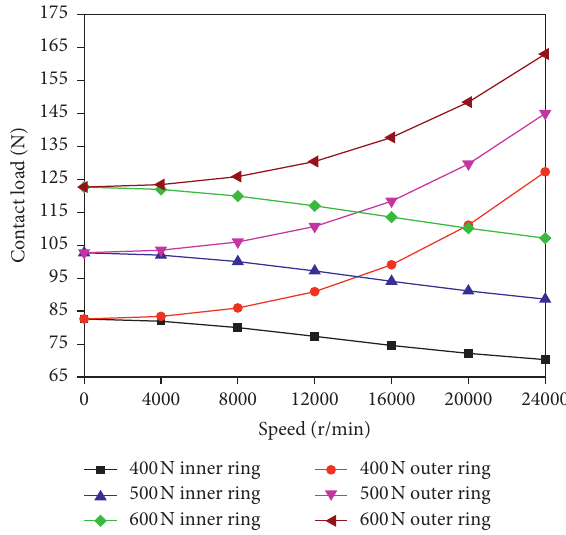
Figure 11: Influences of the speed and preload on contact